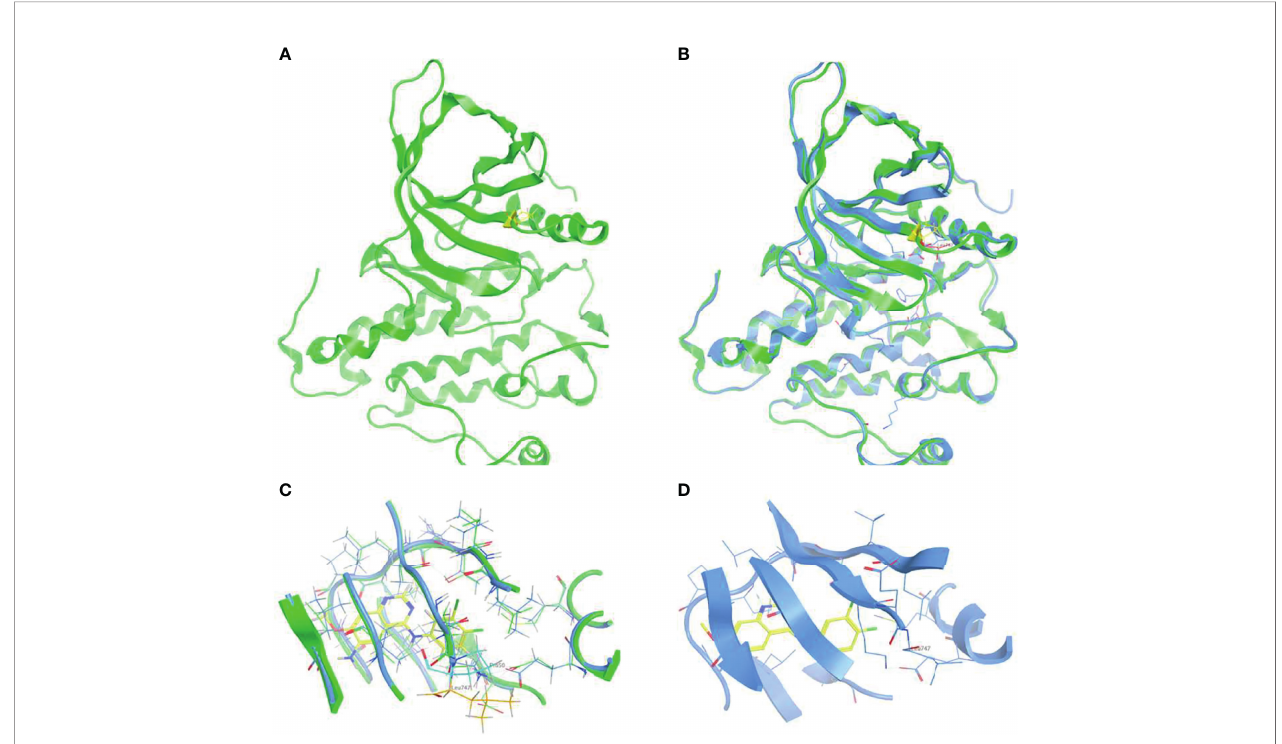
FIGURE 1 | 3D-modeling of p.L747P conformation (A) and crystal structure of EGFR wild type kinase domain in complex with dacomitinib (B) . ATP-binding pocket in the activating kinase domain of EGFR wild type (C) and p.L747P conformation (D)